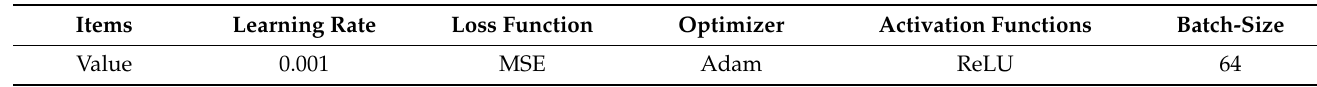
Table 7. Model parameters